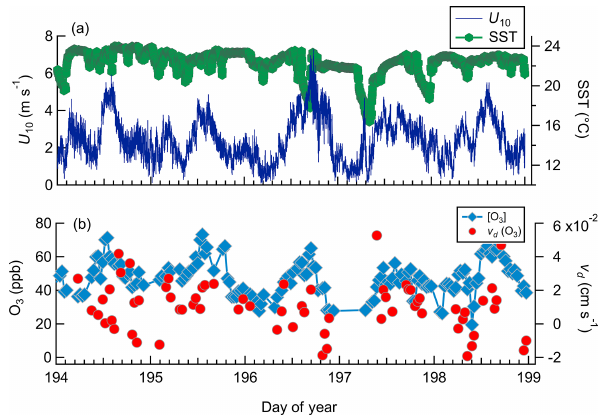
Figure 9. Observed meteorology and O 3 mixing ratio and deposi- tion velocities for day-of-year 194–199 from Scripps Pier. (a) Hori- zontal wind speed ( U 10 ) and sea surface temperature (SST). (b) O 3 mixing ratios and v d (O 3 ).